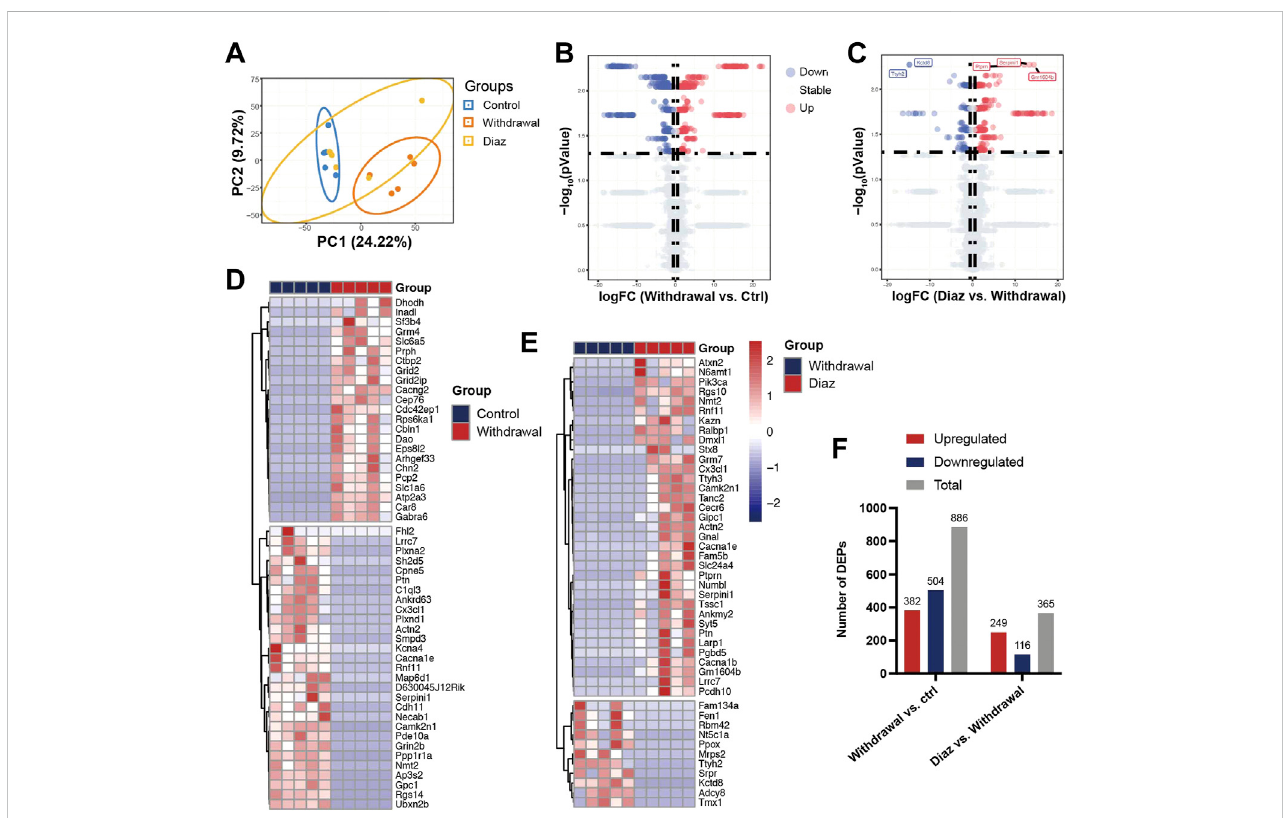
FIGURE 2 Identi fi cationofDEPs. (A) PCAplotsofControl(blue),Withdrawal(orange)andDiazepam(yellow)Groupsin15sampleswithovalcon fi denceintervals. (B) Volcano plotofControl andWithdrawalGroup samples. (C) VolcanoplotofWithdrawaland Diazepam Groupsamples.Colors represent differentgenes:grey nodes represent proteins without signi fi cantly different expression, red nodes represent upregulated proteins, and blue nodes represent downregulated proteins. (D) Hierarchical clustering heatmap of 52 DEPs (represented by rows) in Control and Withdrawal Group samples (represented by columns) and (E) 46DEPsinWithdrawalandDiazepamGroupsamples.Colorsrepresentrelativeabundanceofproteinsusingnormalizedintensitydata. (F) NumberofDEPs in Withdrawal versus Control and Diazepam versus Withdrawal Group samples. Red bar represents upregulated DEPs. Blue represents downregulated DEPs. Grey represents total